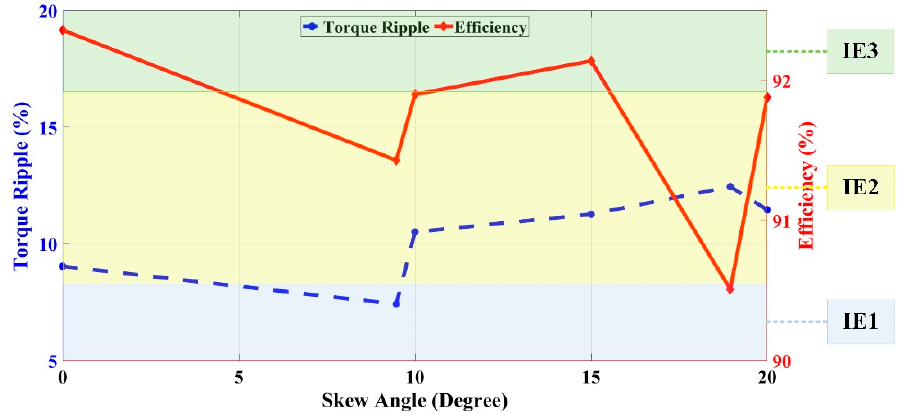
Figure 10. Efficiency and torque results of AFIM with 38 slots.